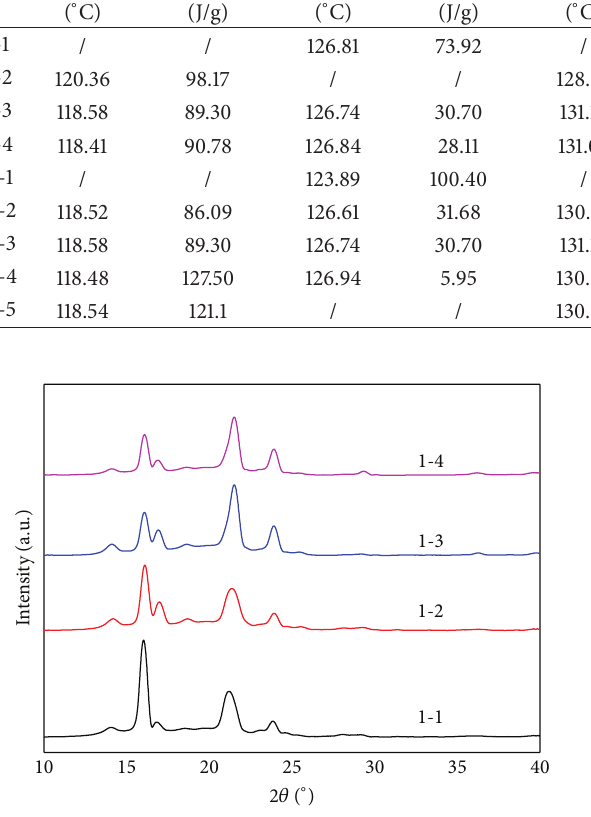
Figure 1: WAXD spectra of PP with the different AA-RCC content.